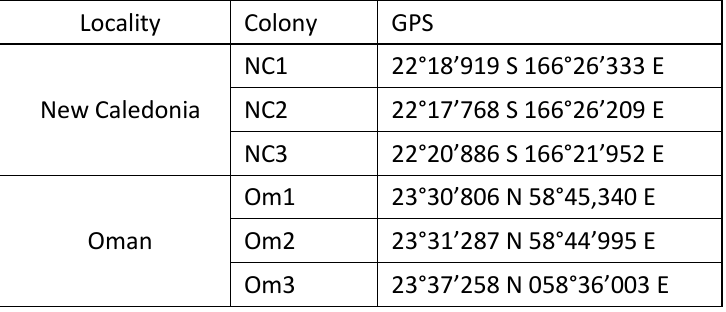
Table 2. Sea Surface Temperatures (SST) to which the colonies sampled in this study are exposed in their natural environments. Thermal regime descriptors were compiled from weekly mean sea surface temperature data collected from the Integrated Global Ocean Services System Products Bulletin